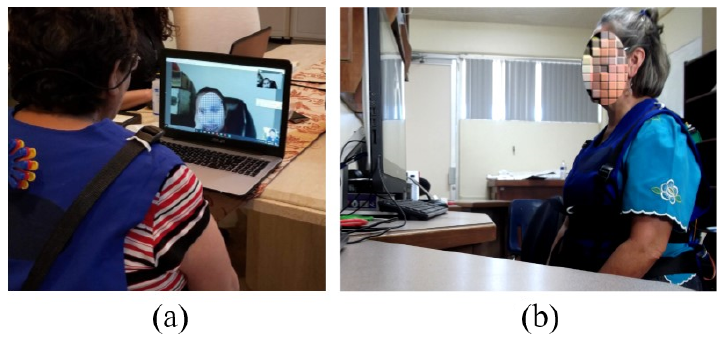
Figure 9. ( a , b ) Participants in stage